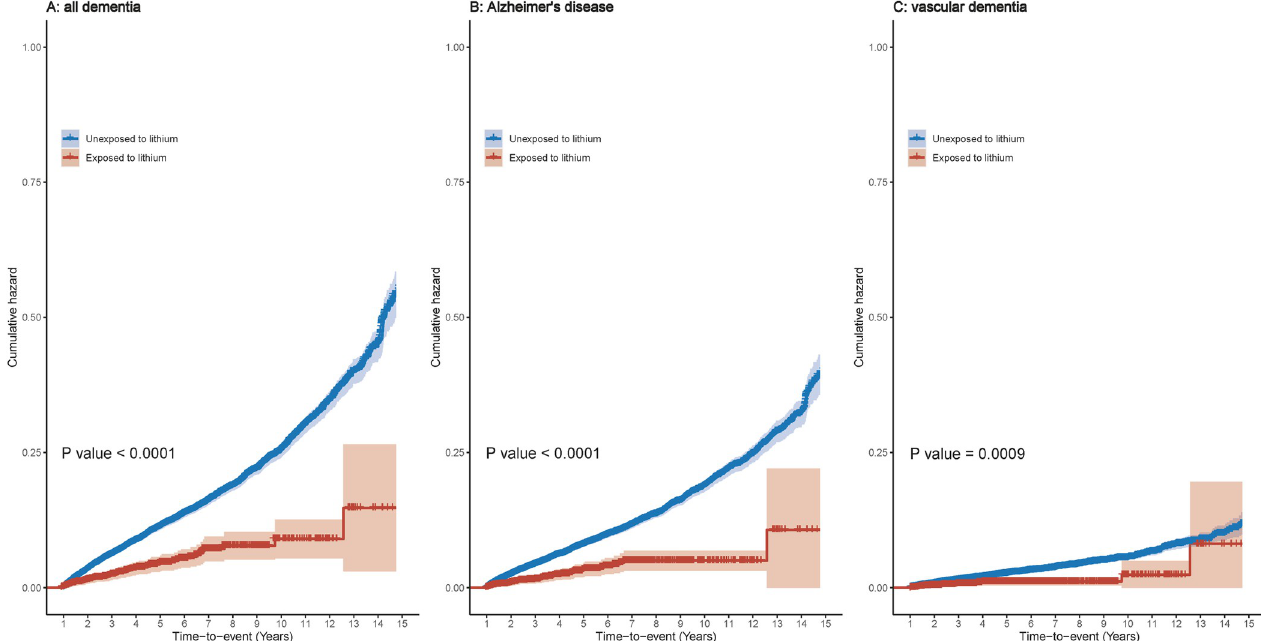
Fig 2. Cumulative hazard of dementia and its subtypes in lithium users versus nonusers. p -Values are calculated from the log-rank test after IPW. IPW, inverse probability weights/weighting.